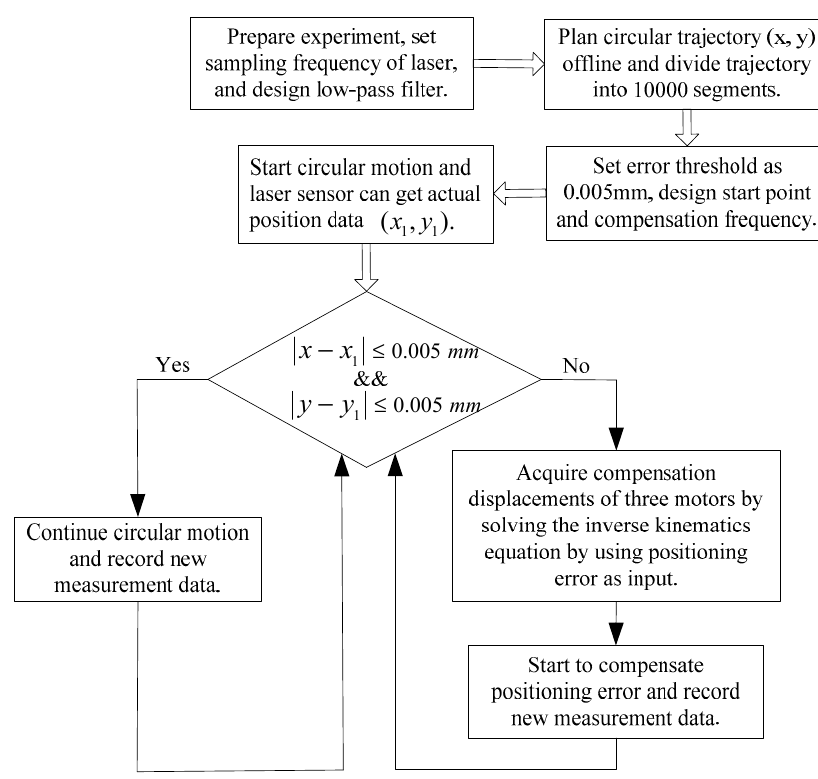
Sensors 2019 , 19 , x FOR PEER REVIEW Figure 10. Flow chart of the closed-loop control experiment of the 3-PRR parallel platform.